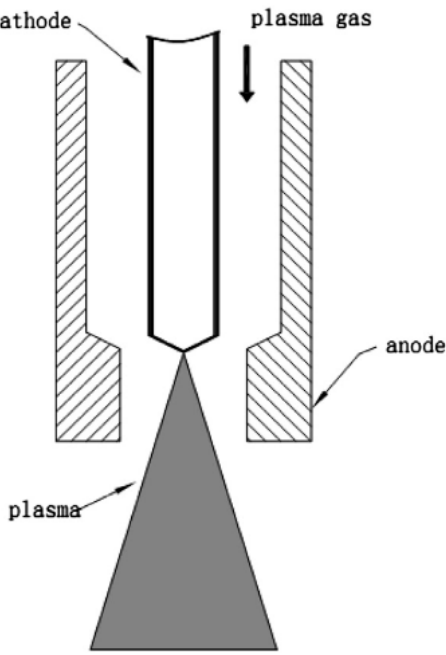
Figure 3. DC non-transferred thermal plasma [31].